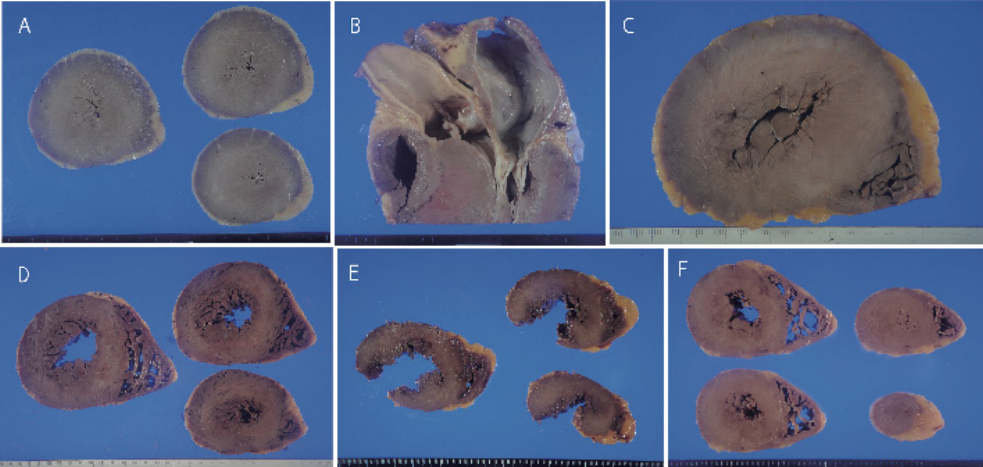
Figure 1. Gross appearance of the heart. A ; Marked concentric left ventricular hypertrophy in Case 1. B ; Asymmetric septal hypertrophy in Case 1. C ; Marked concentric hypertrophy in Case 2. D ; Moderate left ventricular hypertrophy in Cases 5 ( D ) and 6. E, F; Mild hypertrophy of the left ventricle in the hearts of Cases 7 ( E ) and 8 ( F ). The left lateral wall in Case 7 was ruptured by a traffic accident.